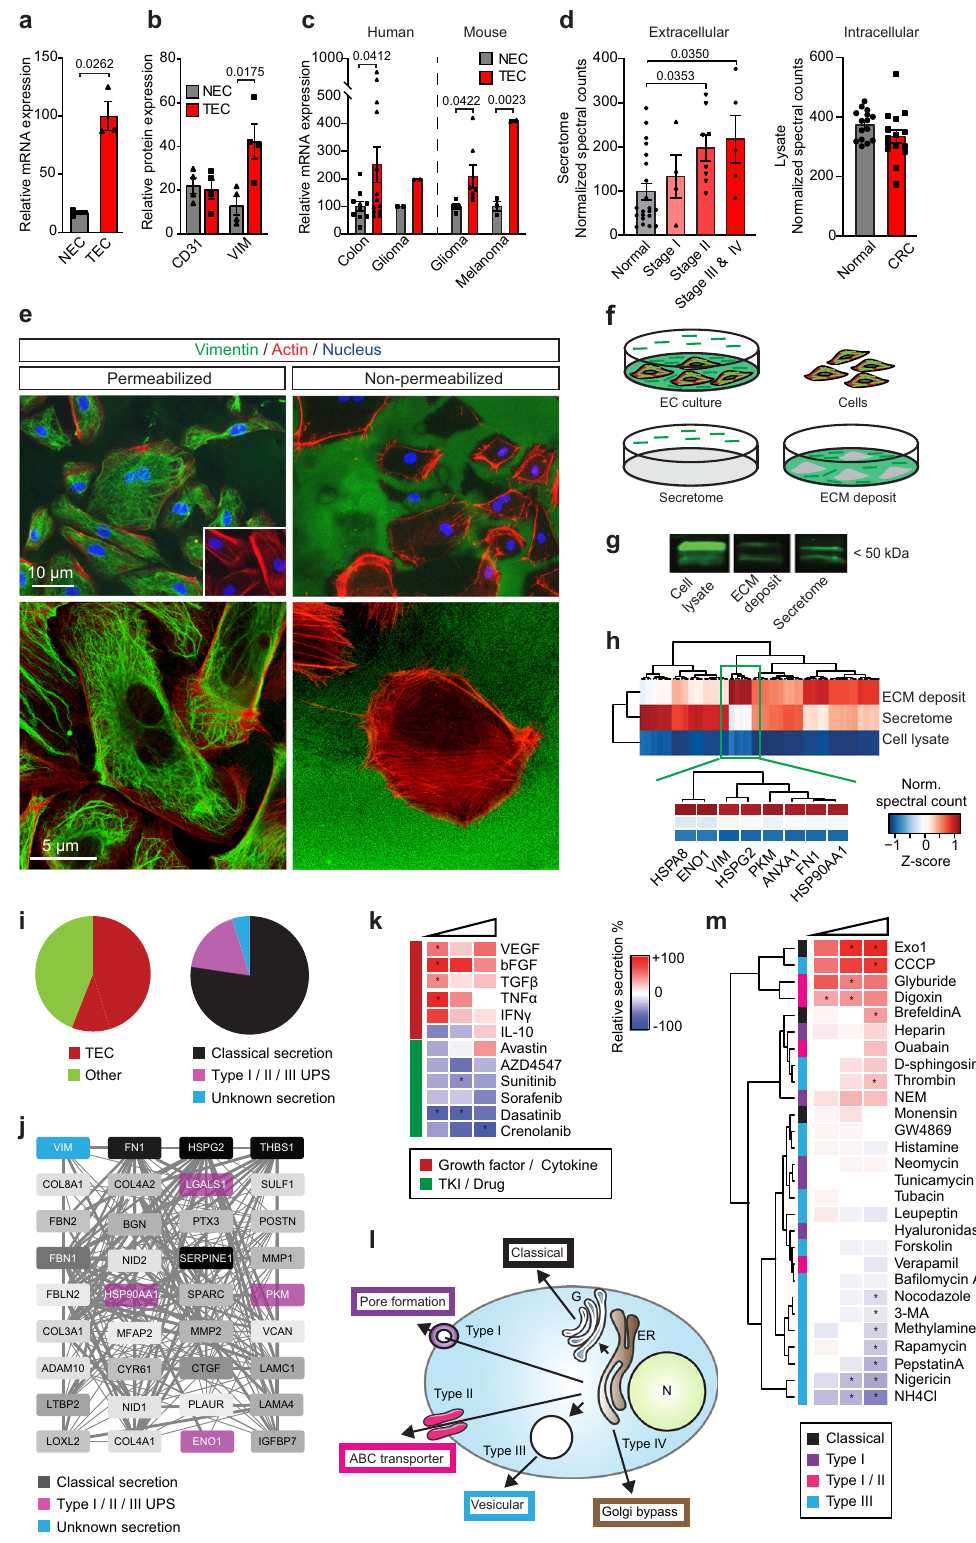
Extracellular vimentin promotes a pro-angiogenic phenotype . Exposure of ECs to recombinant extracellular vimentin dose- dependently increased sprouting of ECs in collagen gels (Fig. 2a), while cell viability and migration were not signi fi cantly affected (Supplementary Fig. 3a, b). Notably, we observed that in the presence of extracellular vimentin, though not in response to